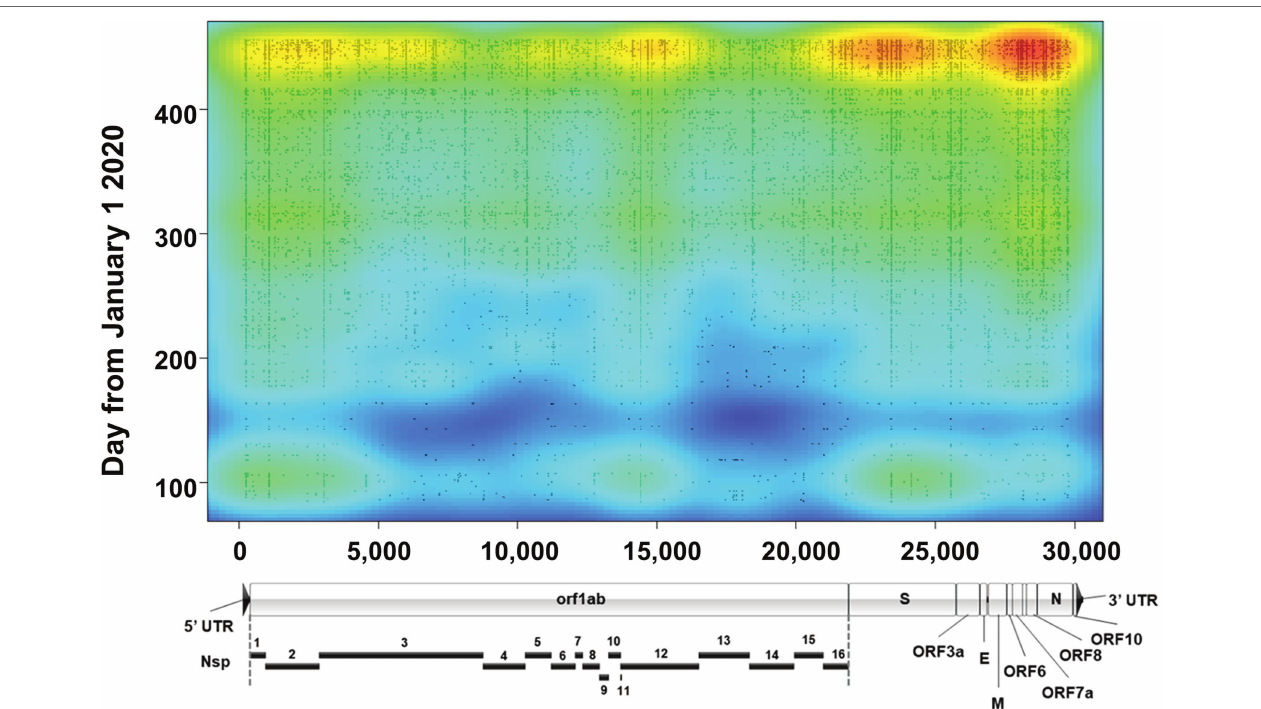
FIGURE 7 | Severe acute respiratory syndrome coronavirus 2 variation. Plot shows a heat map of genomic variation relative to the Wuhan-Hu-1 reference genome. Areas of low and high variation are shown as blue and red, respectively. Plot is overlayed with individual dots that denote the locations of high-quality variants (both consensus and minor variants) identified in all sequenced samples as a function of time ( y axis). For reference, a to-scale map of the genome is shown below with known proteins labeled. Nsp, nonstructural protein.